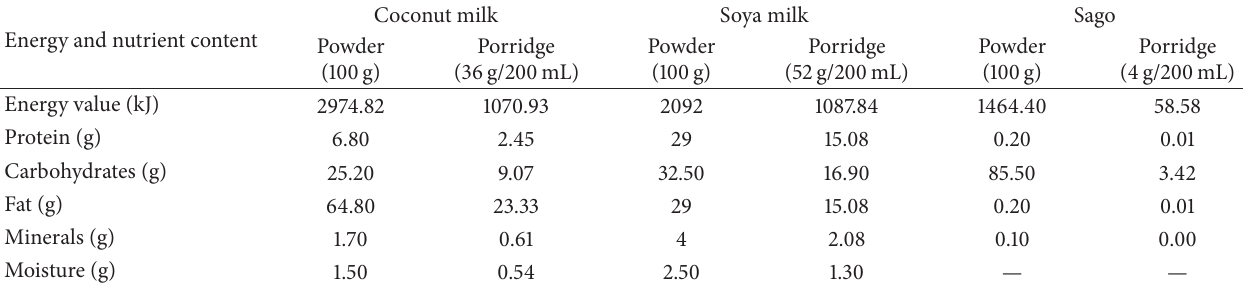
Table 1: Nutritional composition of coconut milk and soya milk powder and added sago in 200 mL of porridge. Energy and nutrient